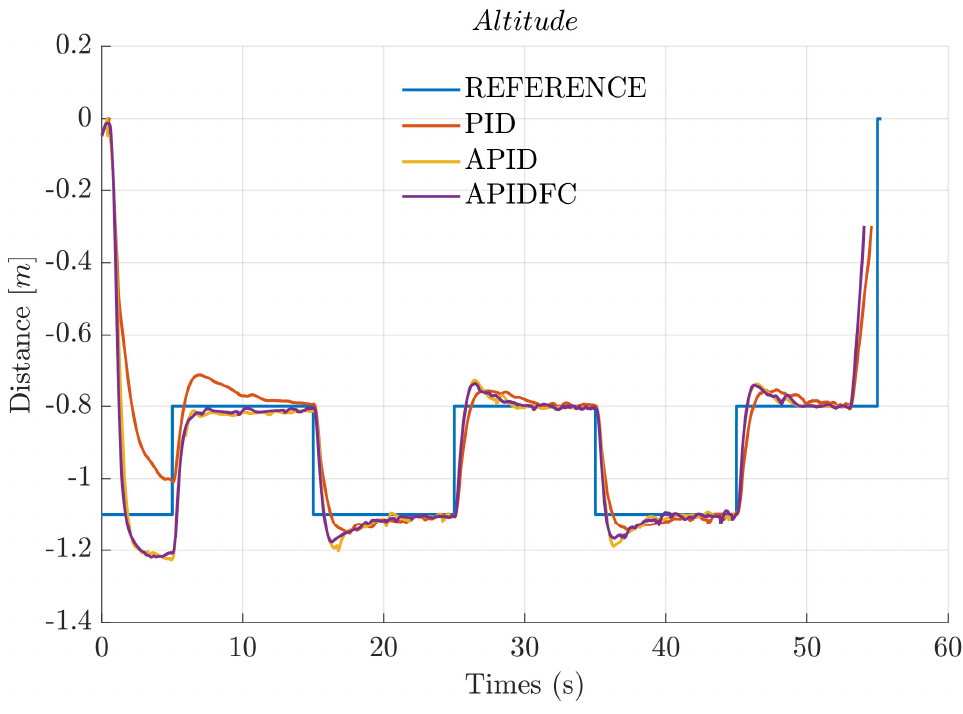
Figure 17. Altitude response to following the square wave reference.